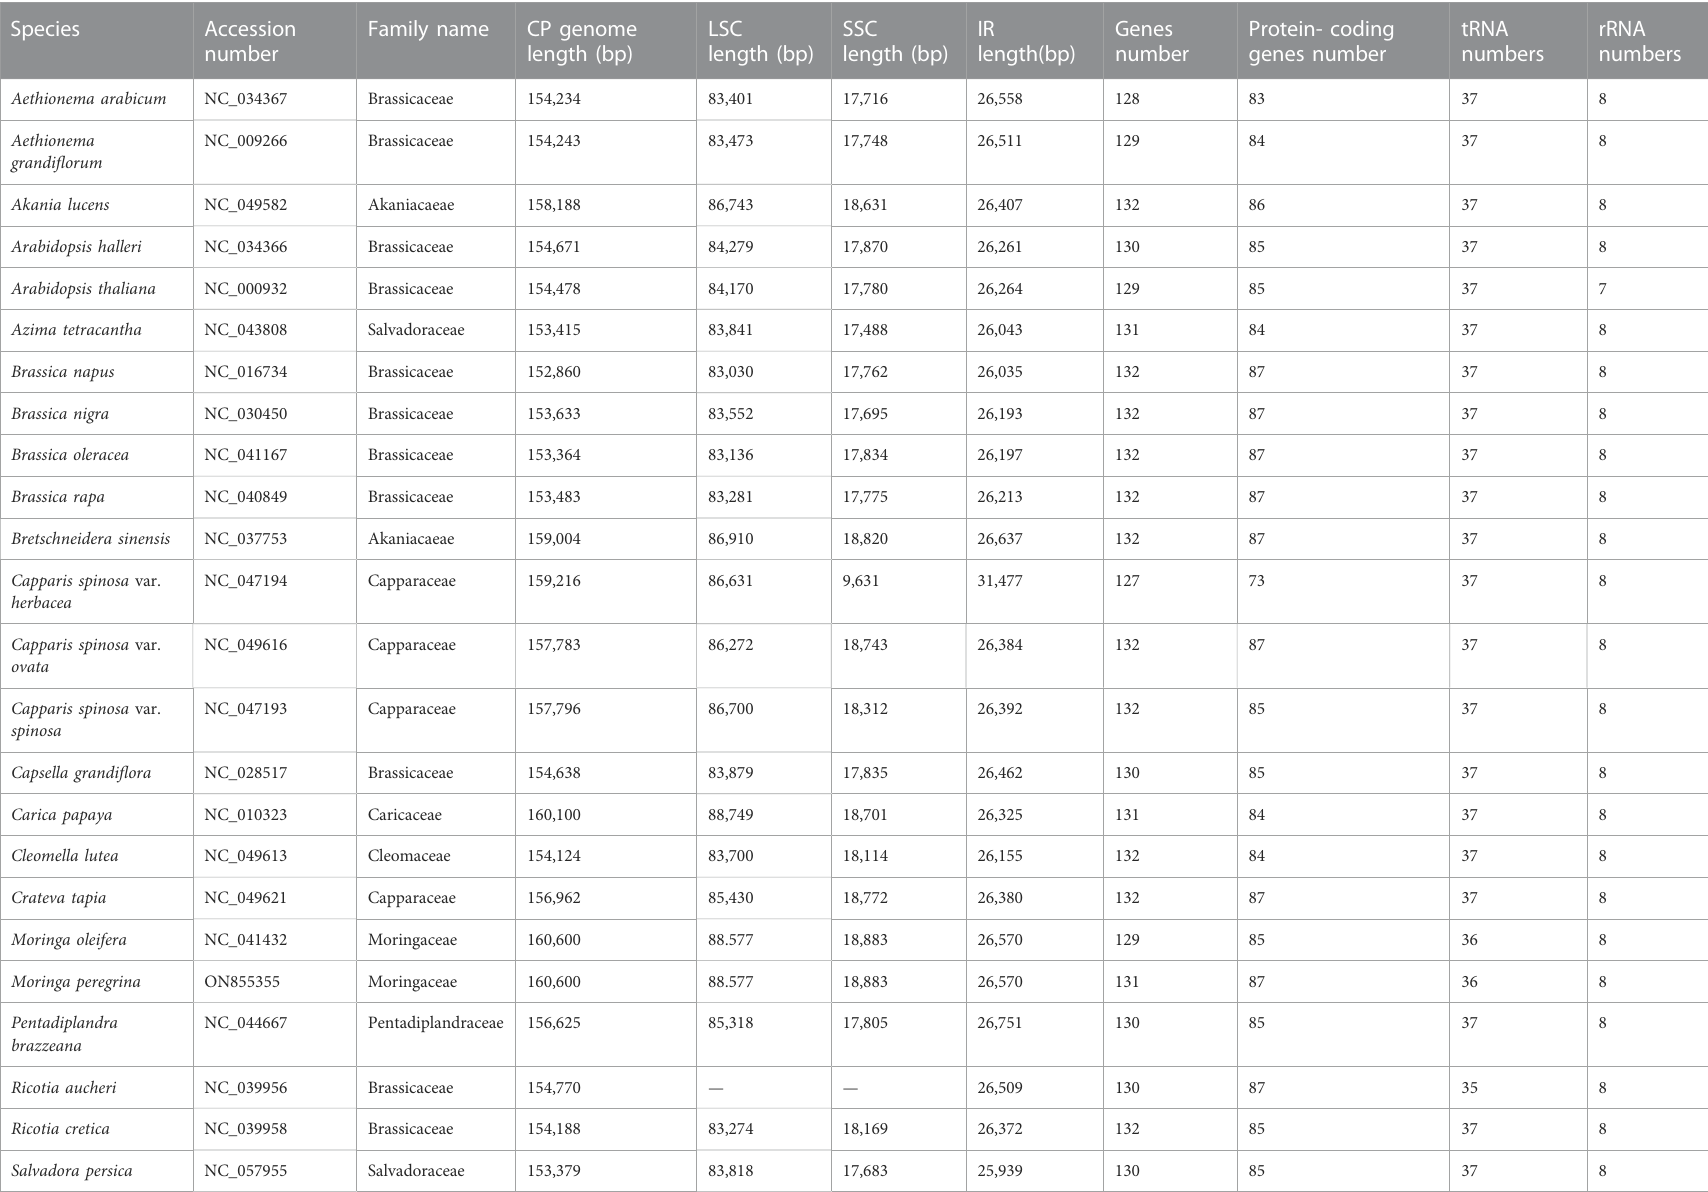
TABLE 3 Summary of annotated features of 26 relative ’ s